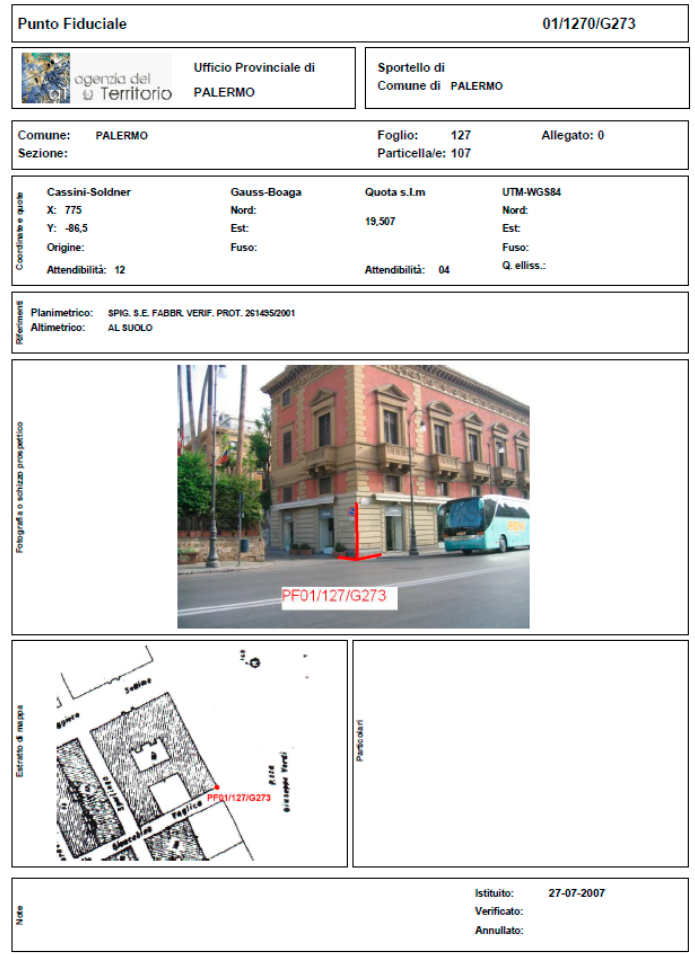
Figure 1. An example of AE monographs with PF coordinates georeferenced in the Cassini-Solder system (in Italian).